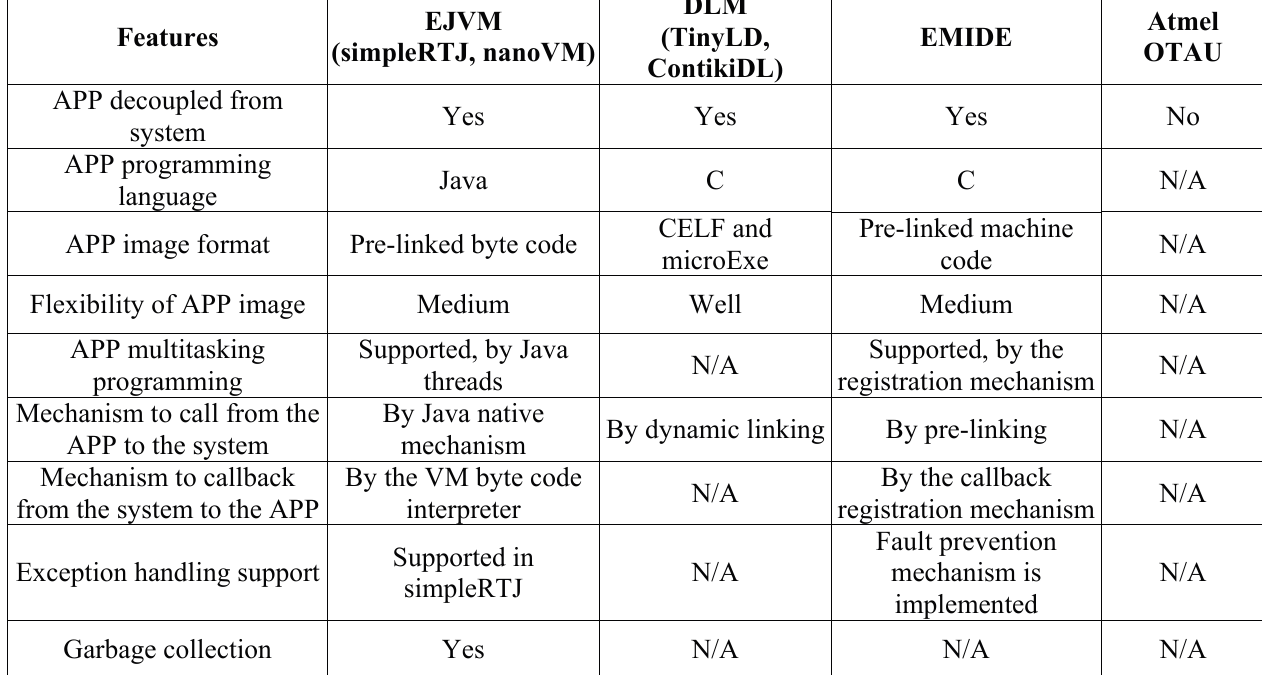
Table 6. Feature comparison of the EJVM, the DLM, the EMIDE and the Atmel OTAU.